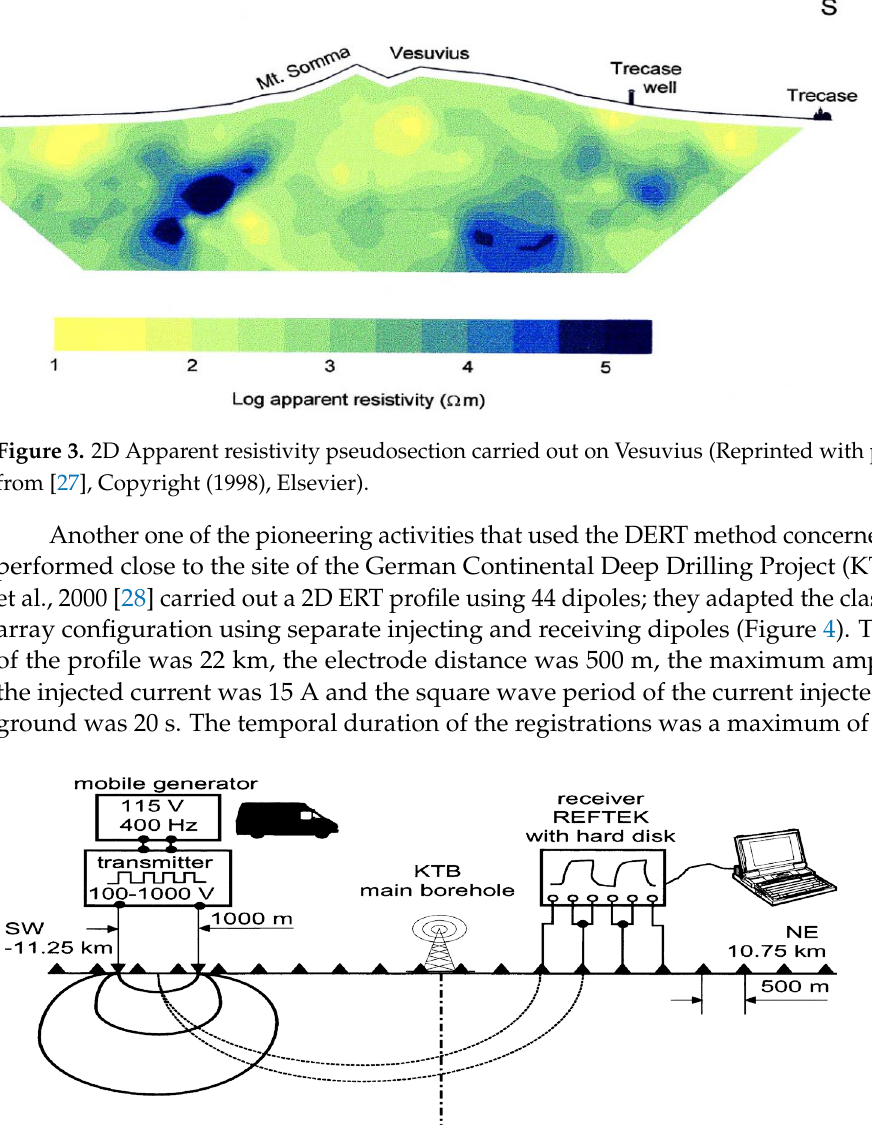
Figure 4. Schematic description of the field procedure adopted for the deep ERT carried out close to the KTB drill project facility. (Reprinted with permission from [28], Copyright (2000), Wiley-Blackwell Publishing Ltd.).